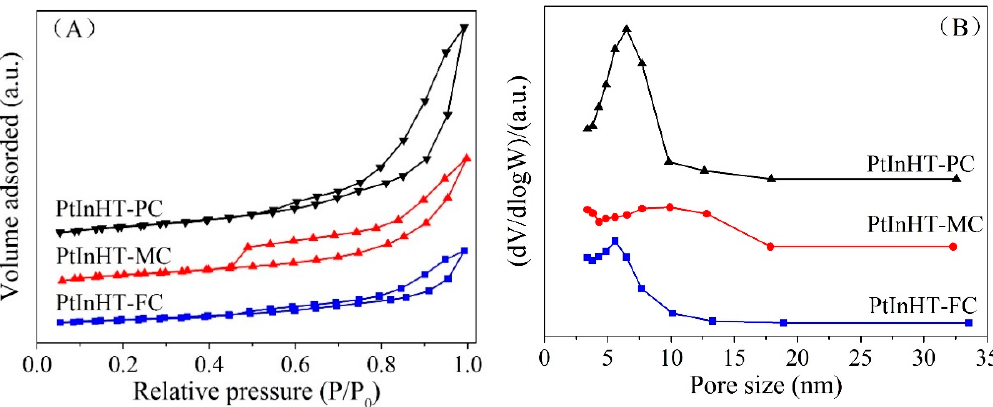
Figure 4. ( A ) Low temperature N 2 adsorption-desorption isotherms and ( B ) PSD curves of di ff erent catalysts. Table 2. Textural properties and the dispersion degree of Pt (DPt) for PtInHT-XC catalysts. Sample